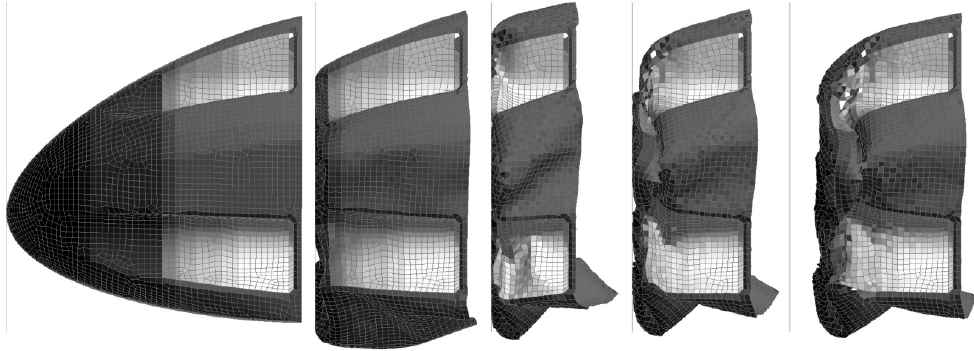
Figure 28. D3Plot images of wall hitting nose cone at 0, 0.25, 0.5, 0.75 and 0.1 s of LS-Dyna model with settings All Slim = 1.0, TSize = 1 × 10 − 9 , Erods = 1.0, Soft = 0.0 and FS = − 1.0.